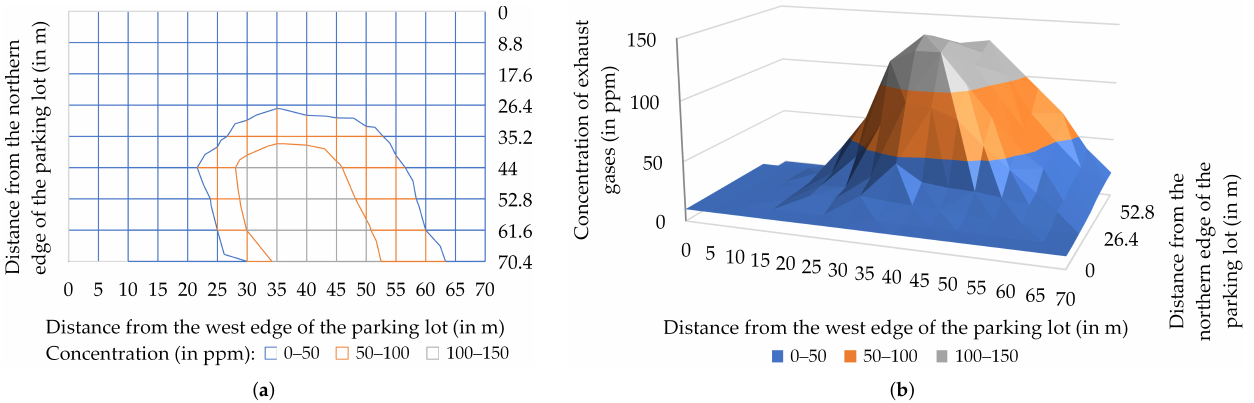
Figure 11. Concentration of exhaust gases (in ppm) measured during experiment 1: ( a ) wireframe contour chart; ( b ) three-dimensional surface chart. For a better presentation, the surface chart ( b ) is a mirror image of the original chart (in the front there is the northern edge of the parking lot—in the rear, the southern edge; on the left, the west edge; and on the right, the eastern